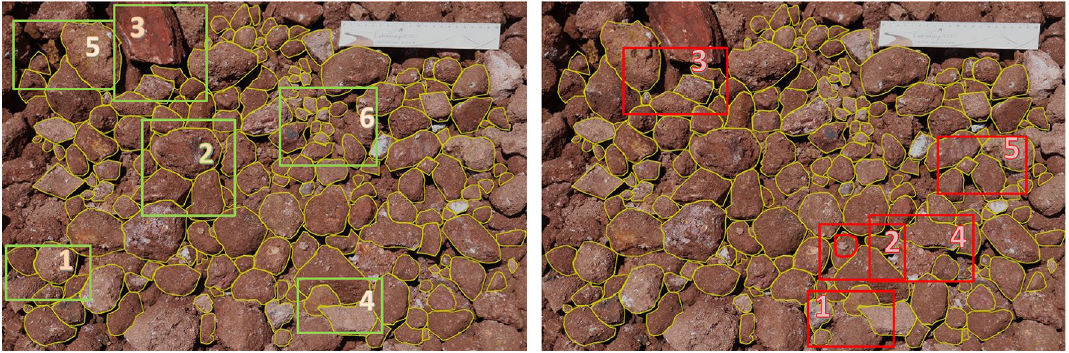
Figure 1. Qualitative guidelines for annotation and labelling of dump particles from